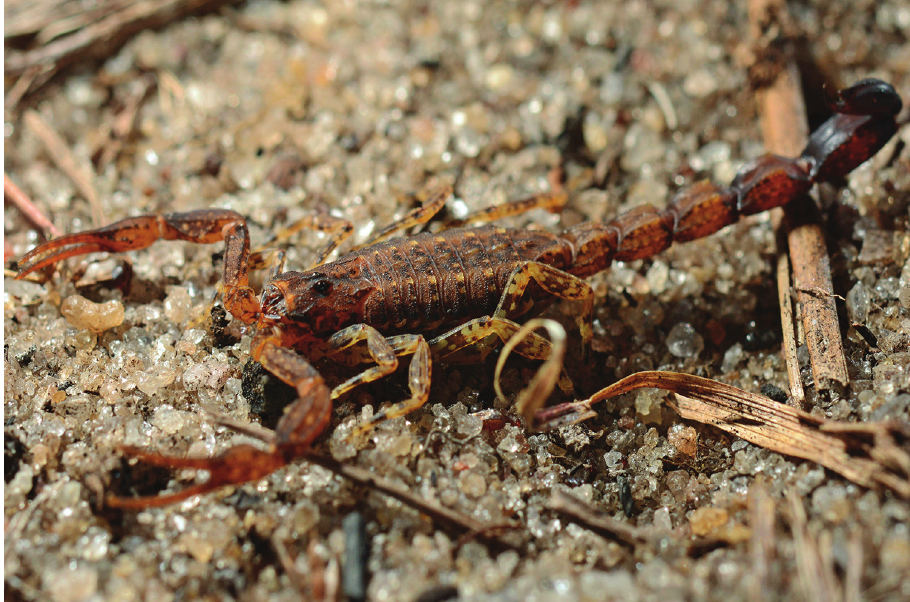
Figure 11. Tityus mana , female from Awala Yalimapo (photo J. Chevalier). median carinae marked only on proximal third; intercarinal spaces weakly granular. Pectines small with moderate fulcra; basal middle lamella not dilated in female; pec- tinal tooth count ranging from 16–17 in male and 14–17 in female. Sternites surface with a residual granulation, almost smooth; carinae absent on III-VI, four weak to moderate carinae on VII; spiracles slit-like but short. Metasomal segments with 10-10- 8-8-5 carinae; dorsal carinae of segments I to IV with one strong distal spinoid granule, better marked in female; intercarinal spaces weakly granular. Telson smooth in males; with one ventral and four vestigial lateral carinae in the female; aculeus shorter than vesicle, moderately curved; subaculear tubercle short and strongly rhomboid, with two dorsal teeth. Pedipalp femur pentacarinate; all carinae moderately to strongly crenu- late; patella with seven carinae; internal carina with strong spinoid granules; chelae with 8–9 strongly marked carinae; all sides weakly granular; carinae and granules better marked in female; dentate margins of fixed and movable fingers composed of 13–14 oblique rows of granules. Ventral aspect of leg tarsi with numerous thin setae; tibial spurs absent; pedal spurs present but vestigial in all